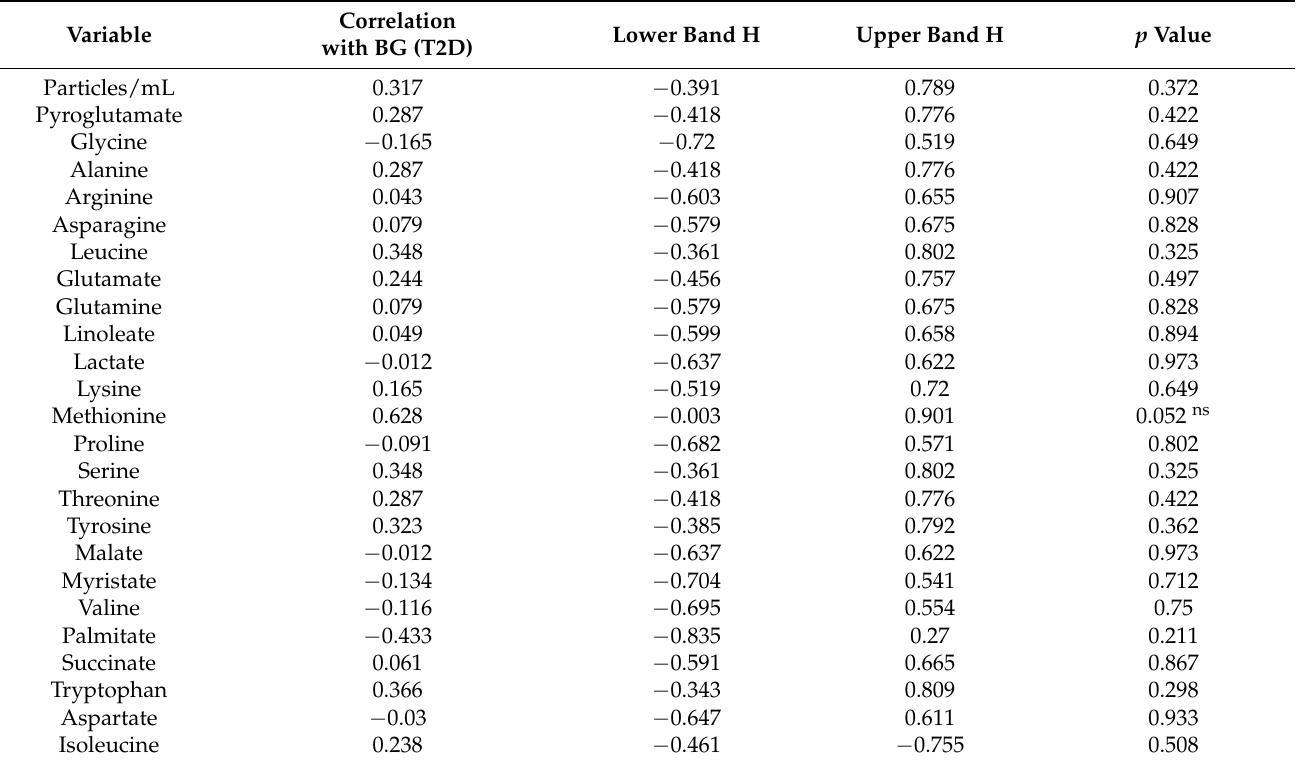
Table 5. Spearman’s rank correlation between blood glucose (before and after heat exposure) and the metabolite levels in the EVs isolated from T2D volunteers ( n = 10) upon heat exposure. ns. not